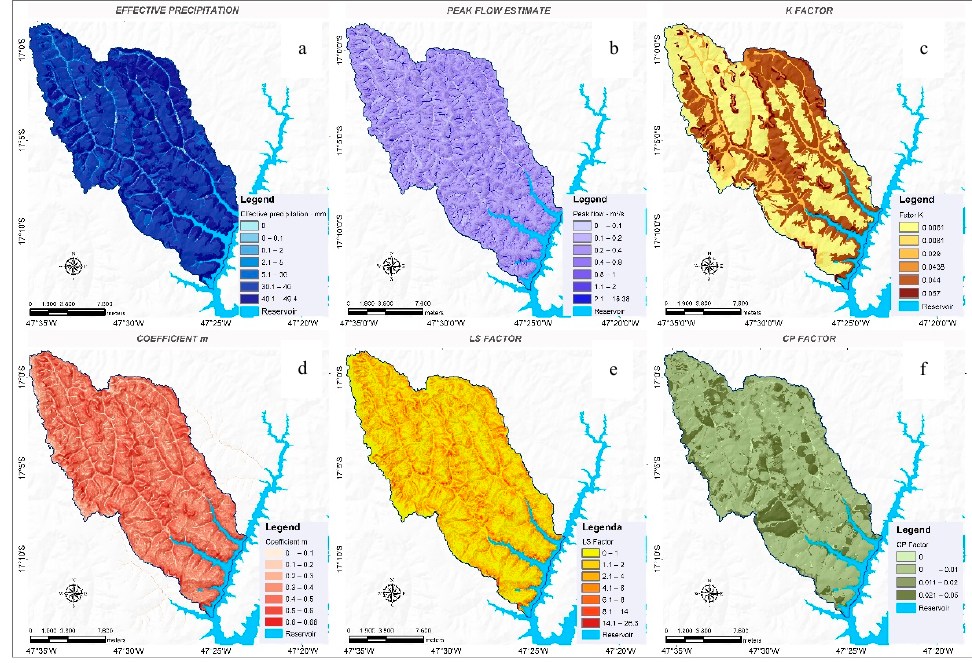
Figure 4. Spatial variability of MUSLE factors: effective precipitation ( a ); peak flow ( b ); soil erodibility ( c ); m coefficient ( d ); LS factor ( e ); and CP factor ( f ).